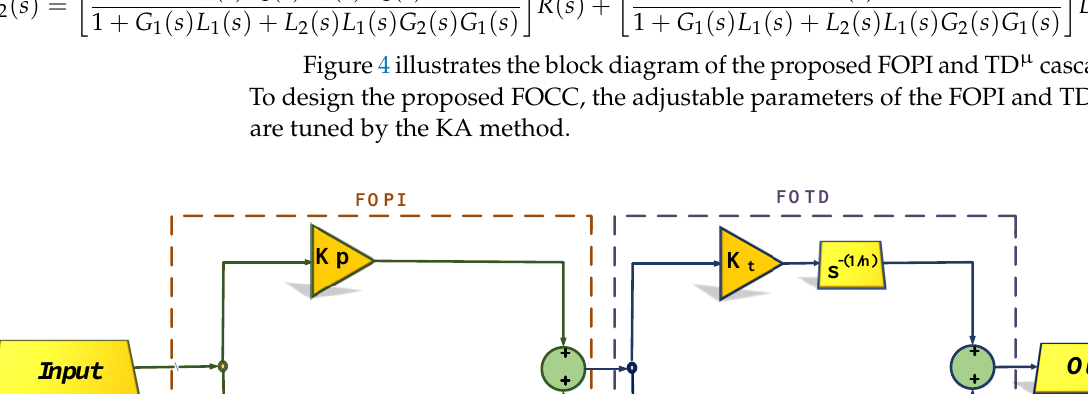
Figure 4. Diagram block of the proposed controller.